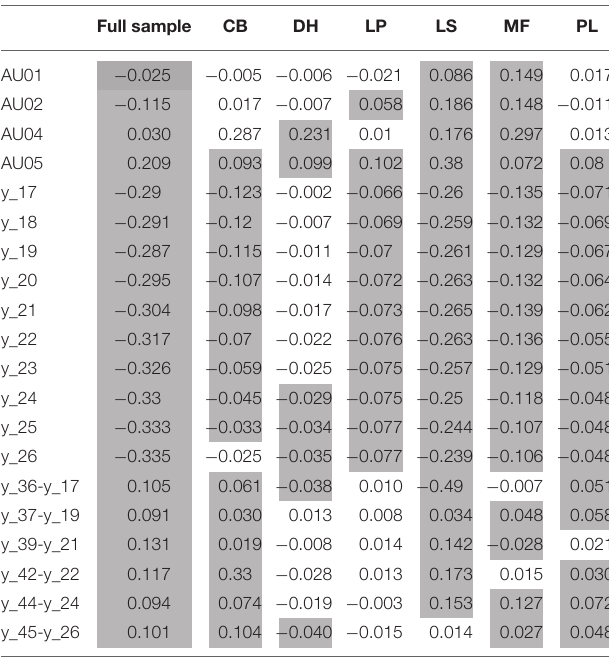
TABLE 3 | Correlation coefficients for the correlations between pitch (in semitones) with the Action Units (AU01–AU05) and the eyebrow-specific facial landmarks (y_17–y_26) for each of the six speakers. Additionally, the correlations between pitch and the distances between the eyebrow and the eye landmarks—used as a measure for eyebrow movement—are